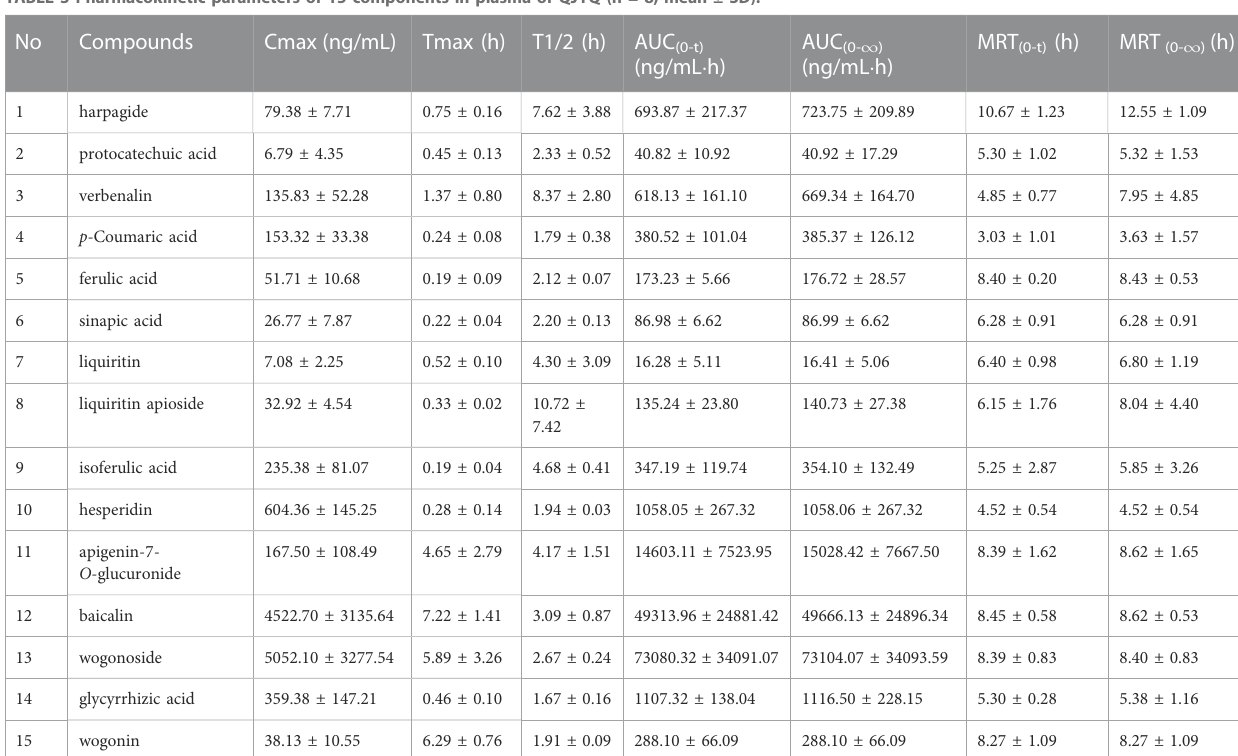
TABLE 3 Pharmacokinetic parameters of 15 components in plasma of QJYQ (n = 8, mean ±